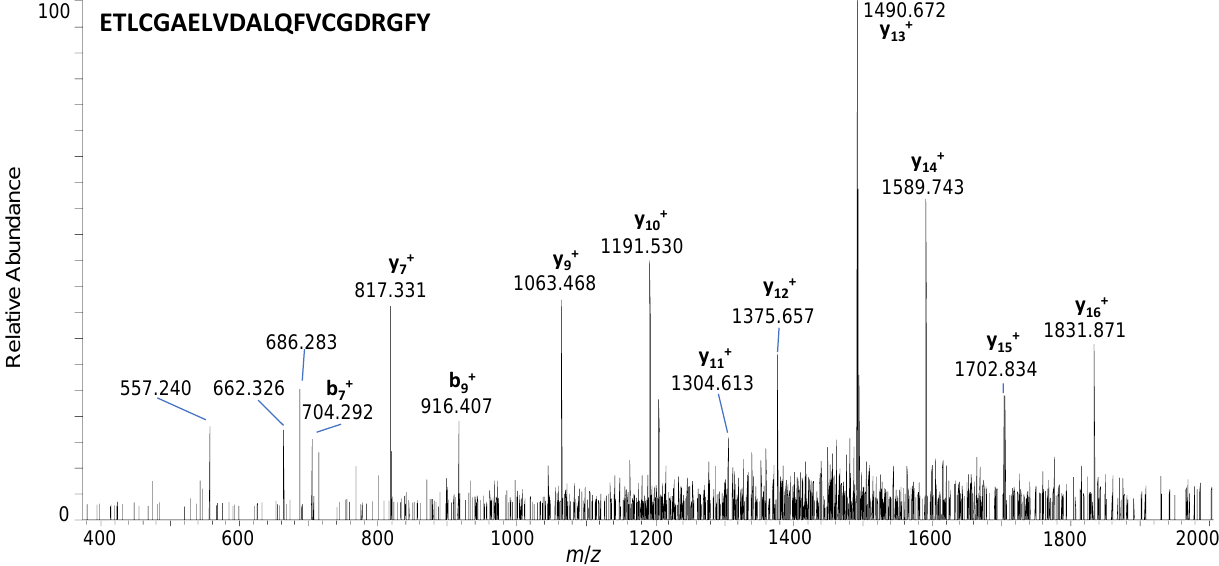
Figure 6. Product ion mass spectrum of unlabelled IGF-I 3–24, generated by incubation of IGF-I in skin S9 mix over 24 h; precursor selected at m / z 1202.551 (z = 2).